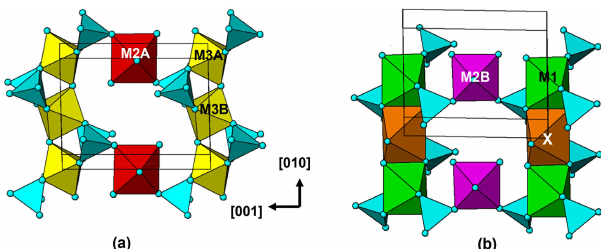
Figure 5. The [100] projections of (a) strunzite-type and (b) large cation-containing (100) layers in the whiteite-type